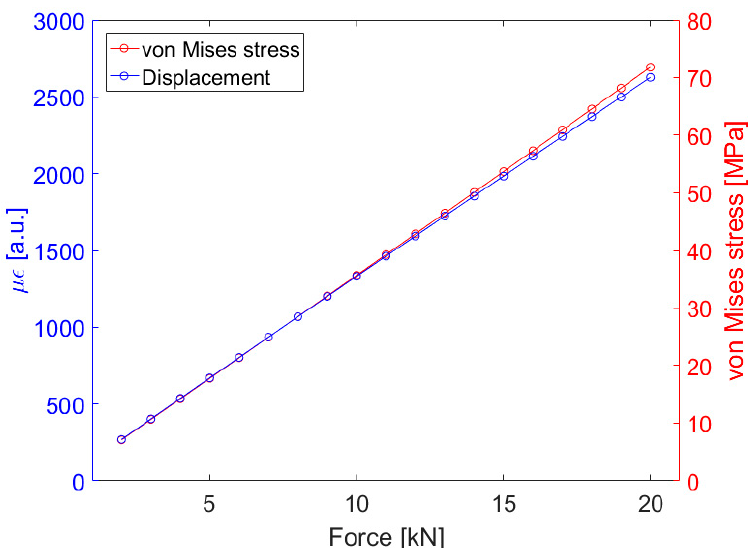
Figure 4. COMSOL simulation results for PEEK sensor. The blue curve (left) shows the strain values ( µε ) and the red curve (right) shows the maximum Von Mises stress values in the sensor structure.